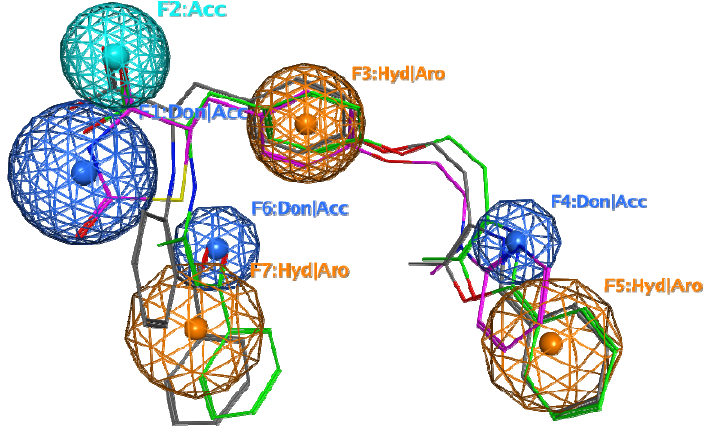
Figure 9. Pharmacophore model of PPAR γ full agonists (rosiglitazone, carbon atoms in magenta; compound 544, carbon atoms in green; compound 570, carbon atoms in